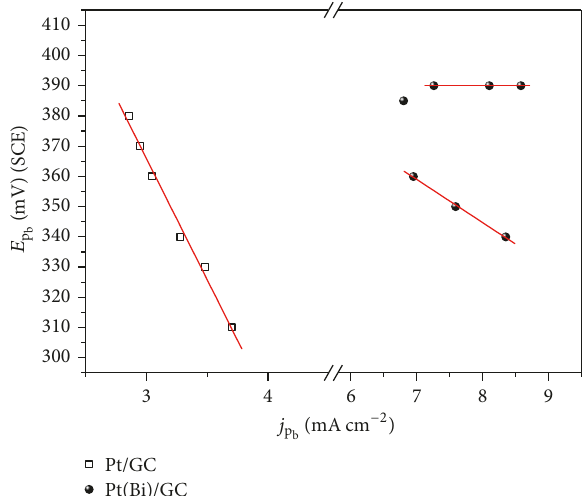
Figure 6: Backward peak potential versus backward peak current (data obtained from Figures 4 and